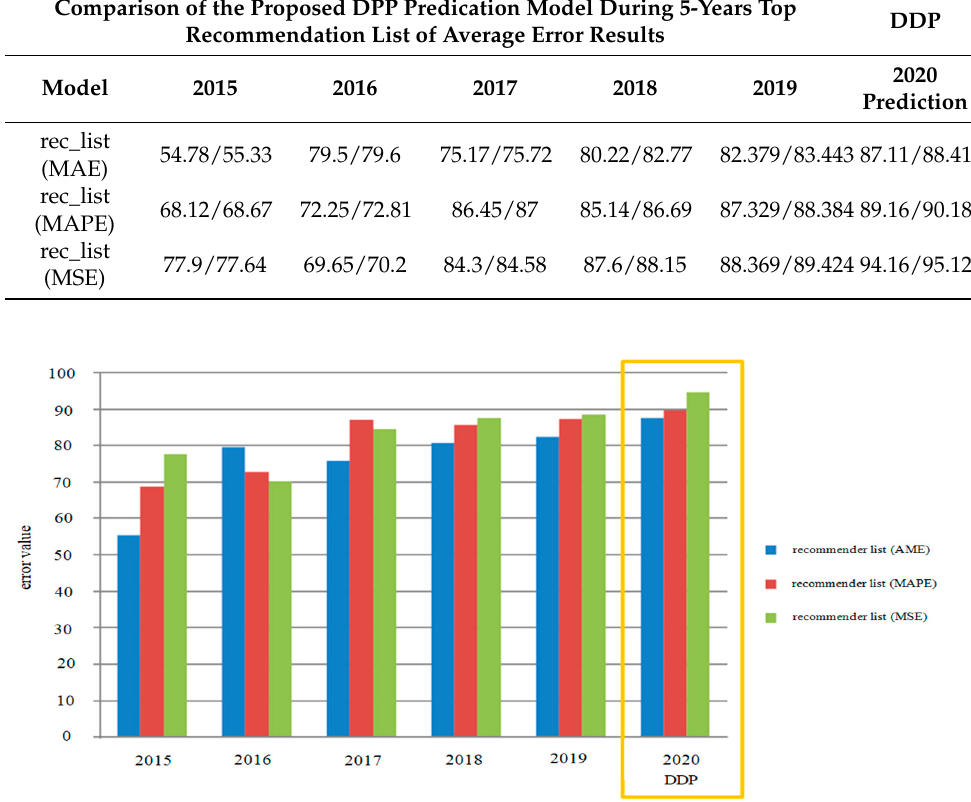
Figure 13. Performance analysis of predication accuracy.